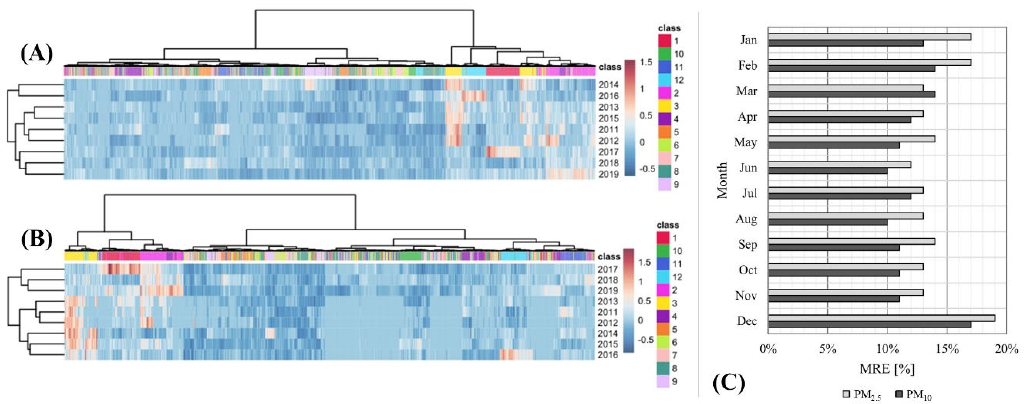
Figure 4. Months clustering according to the comparison of annual and monthly concentrations: ( A ) clustering results of PM 10 , ( B ) PM 2.5 , and ( C ) R 2 from linear regression depending on the months for PM 2.5 ( light gray ) and PM 10 ( dark gray ).